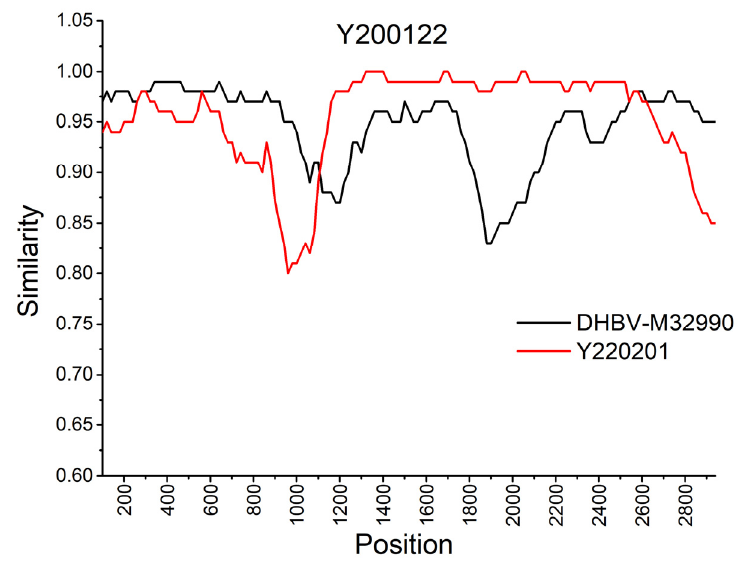
Figure 4. Recombination occurrence in the Y200122 strain analyzed using the Simplot software.